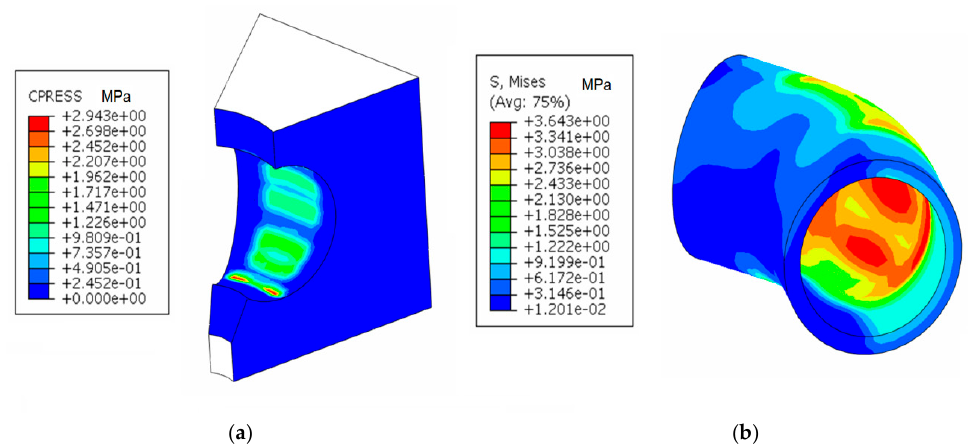
Figure 17. ( a ) Contact pressures on the surface of the massif; ( b ) Polyethylene elbow stresses.